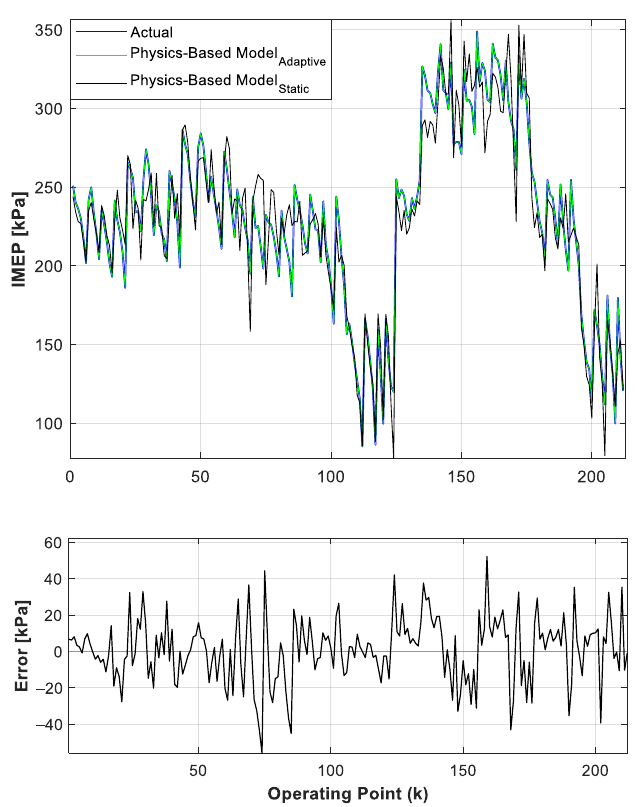
Figure 14. Physics-based IMEP model validation.